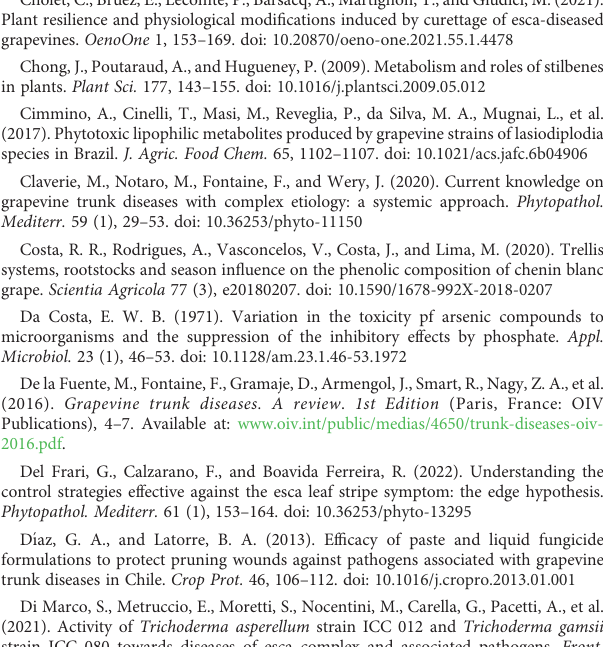
SUPPLEMENTARY FIGURE 1 Observations of woody tissues sampled in the interaction area (WI) of Asn modality, by scanning microscopy coupled with X-ray microanalysis. By this method, we obtained simultaneously surface images (by scanning microscopy; A, C, E, G ) and elemental composition information from a sample (B, D, F, H) . The elements detected in the analyzed spectra were expressed in atomic percentages (B, D, F, H) . This analysis revealed that no trace of Asn could be detected at this time and